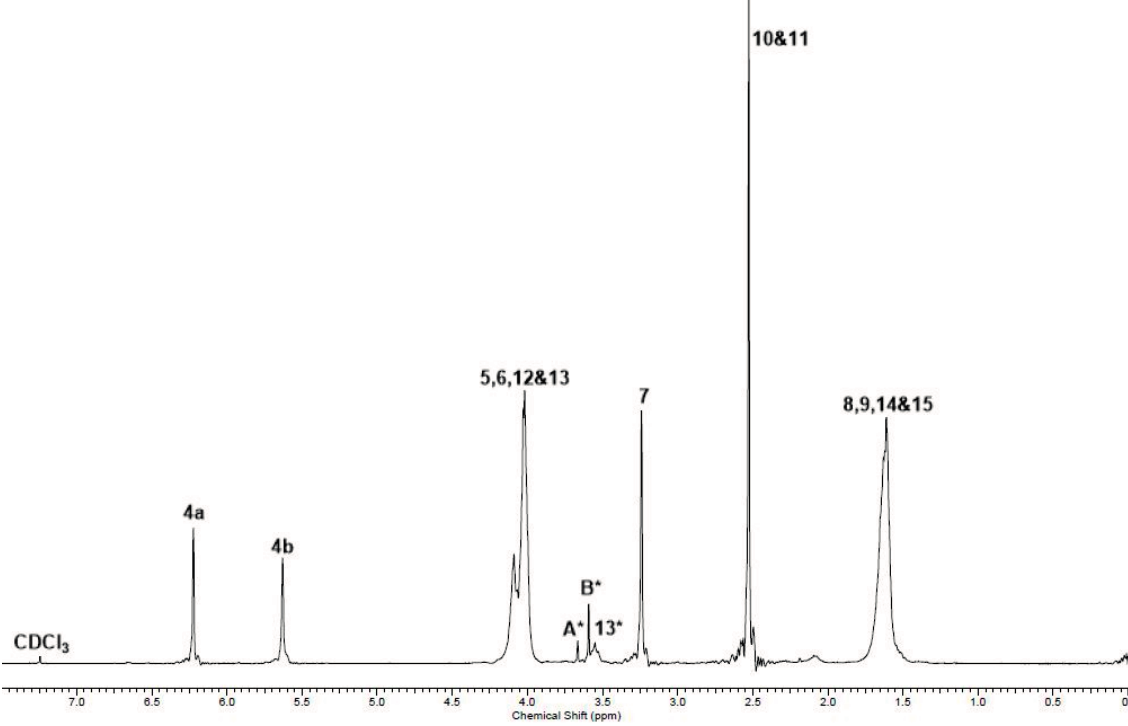
Figure 5. 1 H NMR of PBIBS. The numbered signals (4 to 15) correspond to the